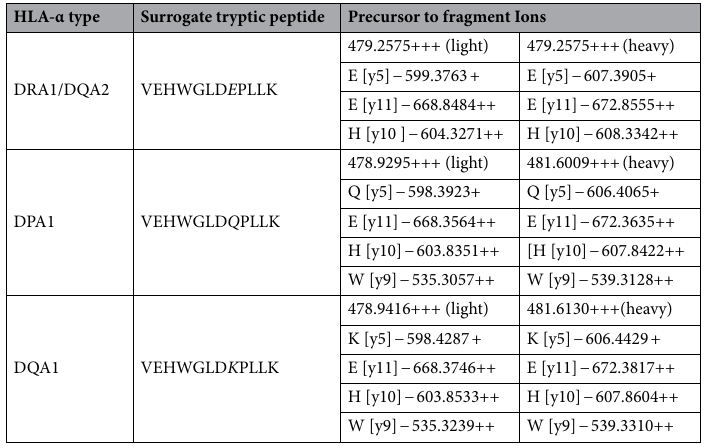
Table 1. Precursor and fragment ion transitions and their charge states monitored by PRM for HLA α-chain quantification.